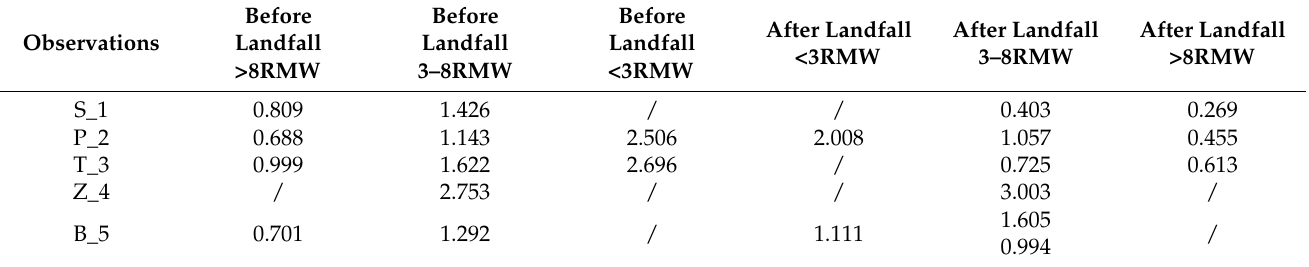
Table 3. Mean TKE (m 2 s − 2 ) of each DWL located at different stages of the typhoon center before and after landfall.